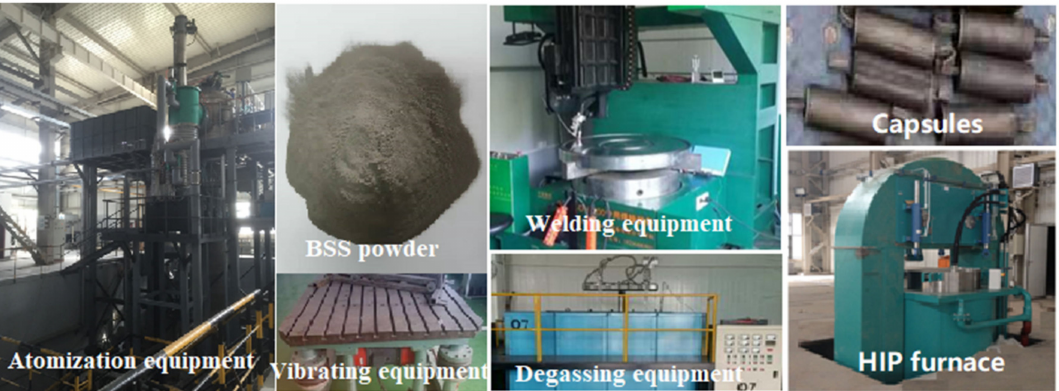
Figure 1. Production equipment, BSS (borated stainless steel) powder, and capsules